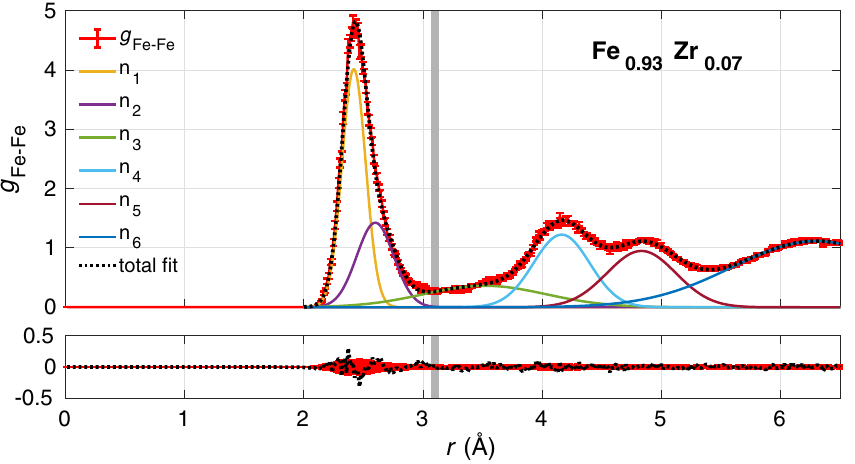
Figure 2. Partial radial distribution function for Fe-Fe pairs in Fe 0.93 Zr 0.07 . The lower panel shows the residual between the sum of the six Gaussians and g Fe − Fe ( r ) obtained from the simulated supercells. The gray vertical line indicates the limit of the first shell. In the lower panel, the difference between the total fit and g Fe − Fe are shown as black points while the standard deviation of the simulated partial radial distribution is indicated in red.